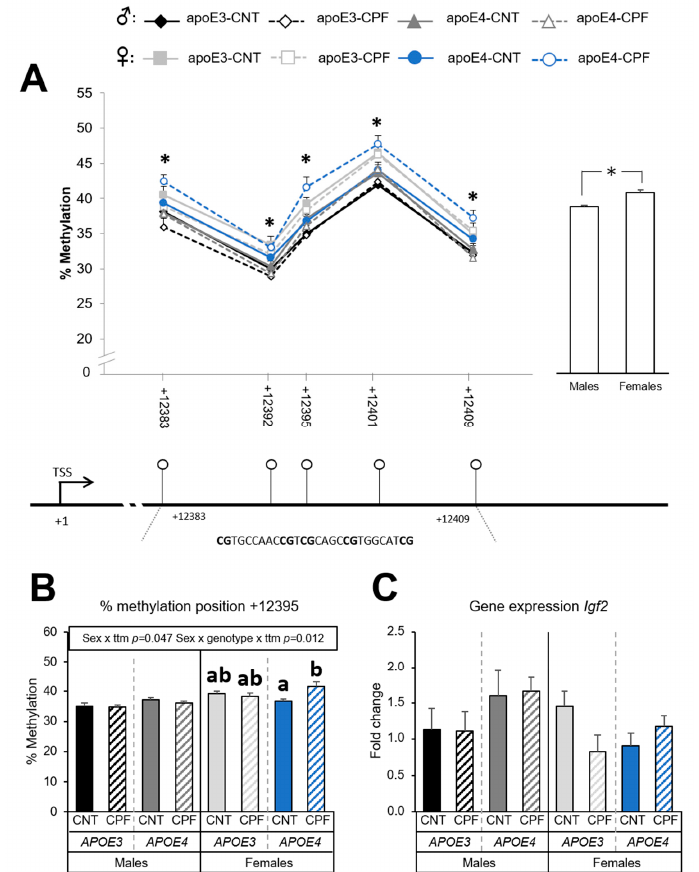
Figure 5. Igf2 gene methylation at the CpG positions studied in the target zone in the DMR2 and overall methylation levels, which are sharing the same y axis. Below, there is the graphical representation of the CpG positions studied and the exact sequence of the target region ( A ). Methylation at the specific position +12,395 ( B ) and gene expression of the Igf2 gene ( C ). All groups included 6 animals except for the APOE3 -CNT that included 5. An asterisk (*) indicates significant differences between groups at p < 0.05. Different letters (a, b) represent significant differences at p < 0.05. Abbreviations: CNT, control; CPF, chlorpyrifos-treated; ttm, treatment. Data is contained within the Supplementary File